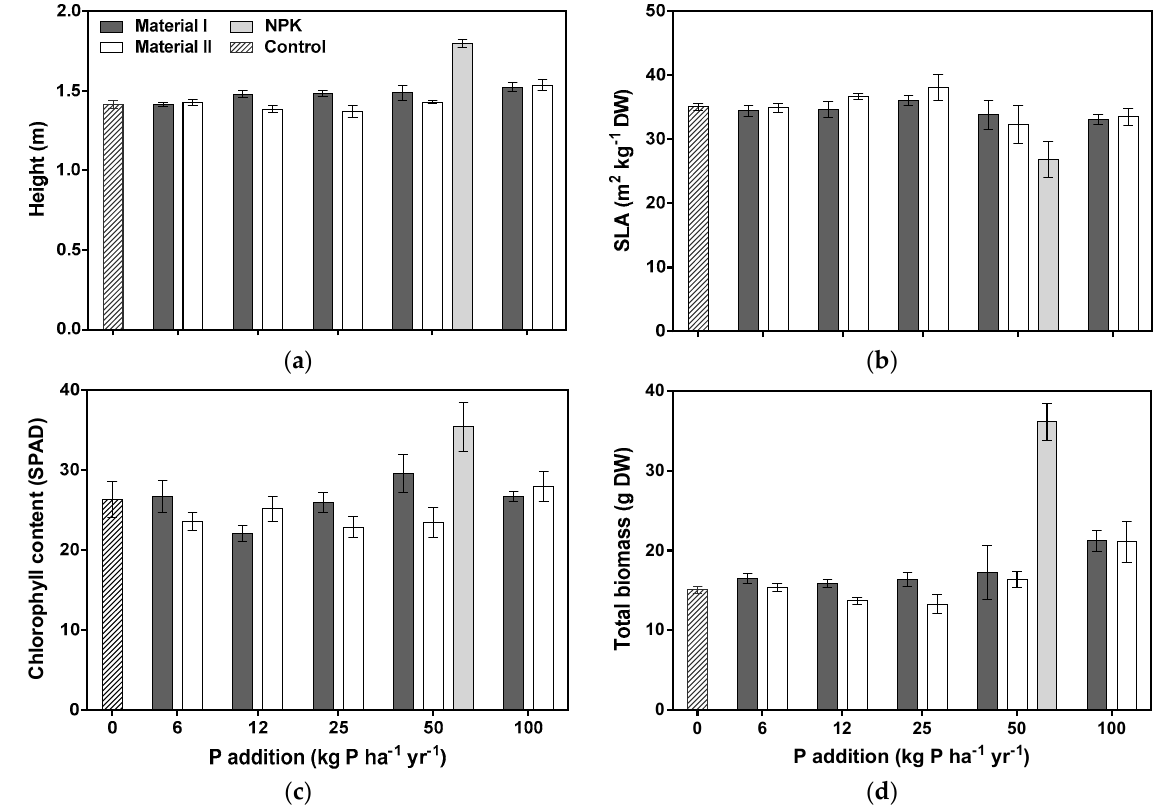
Figure 1. Effects of increasing phosphorus (P) supply when added as P-enriched material (I or II) with five P levels (6, 12, 25, 50, 100 kg P ha − 1 yr − 1 ) on Zea mays ( a ) height (m), ( b ) specific leaf area (SLA; m 2 kg − 1 DW), ( c ) relative chlorophyll content (Chl SPAD ; unitless), and ( d ) total biomass (g DW). The control treatment had no P supplied and the NPK fertilizer treatment had a P supply corresponding to 50 Kg P ha − 1 yr − 1 . The experiment was performed on Zea mays in a growth chamber with controlled conditions and measurements were performed after the plants had grown for eight weeks in the treatments. Values are averages ± SEM ( n =